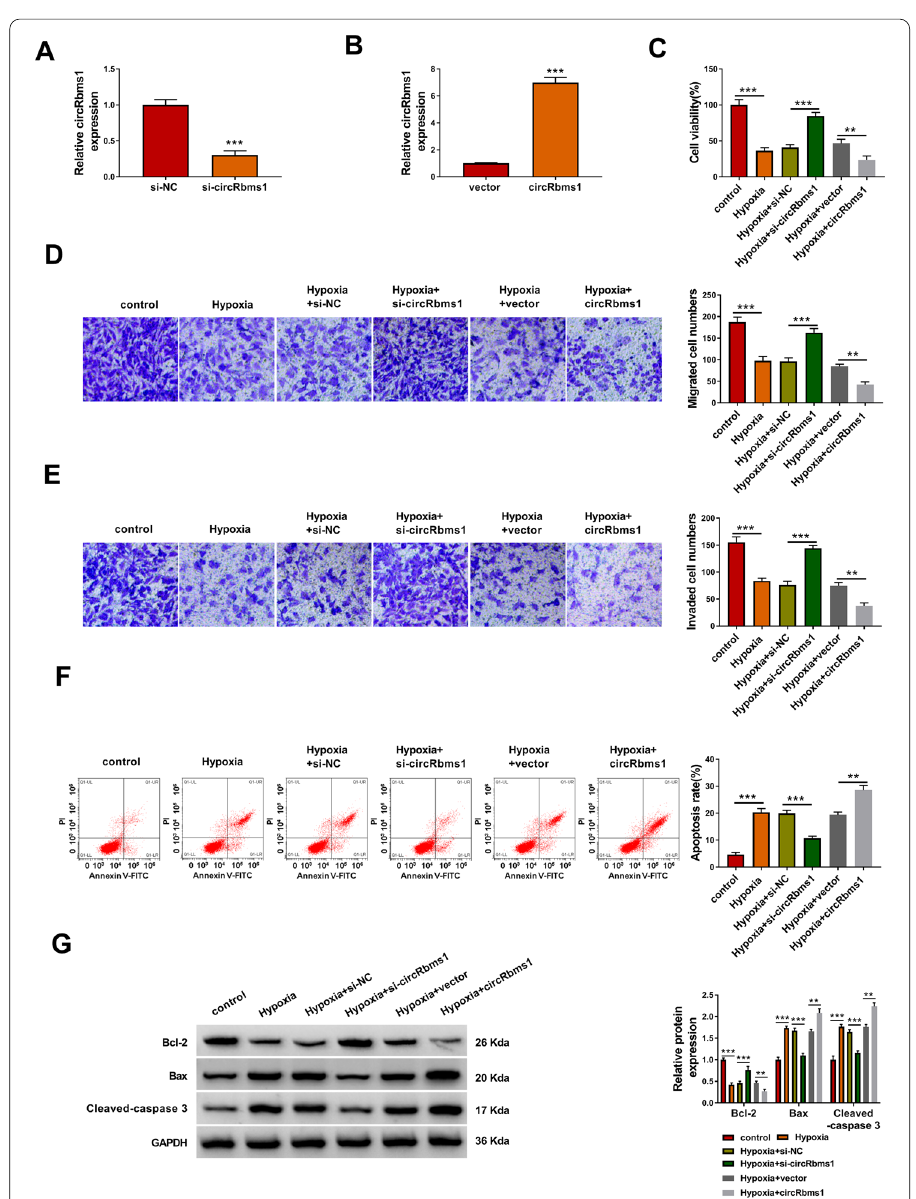
Fig. 2 Knockdown of circRbms1 alleviated hypoxia-induced H9c2 cell injury. A , B qRT-PCR was used to assess circRbms1 expression to evaluate the transfection efficiency of si-circRbms1 (50 nM) or circRbms1 overexpression vector (4.0 µg) in H9c2 cells. C – G H9c2 cells were transfected with or without si-NC (50 nM), si- circRbms1 (50 nM), vector (4.0 µg) or circRbms1 (4.0 µg), and then treated with hypoxia. Untreated H9c2 cells were used as control. CCK8 assay ( C ), transwell assay ( D , E ) and flow cytometry ( F ) were used to determine cell viability, migrated and invaded cell numbers, and cell apoptosis rate, respectively. G WB analysis was performed to test the protein levels of Bcl-2, Bax, and Cleaved-caspase 3. All experiments were repeated three times. ** P < 0.01, *** P <